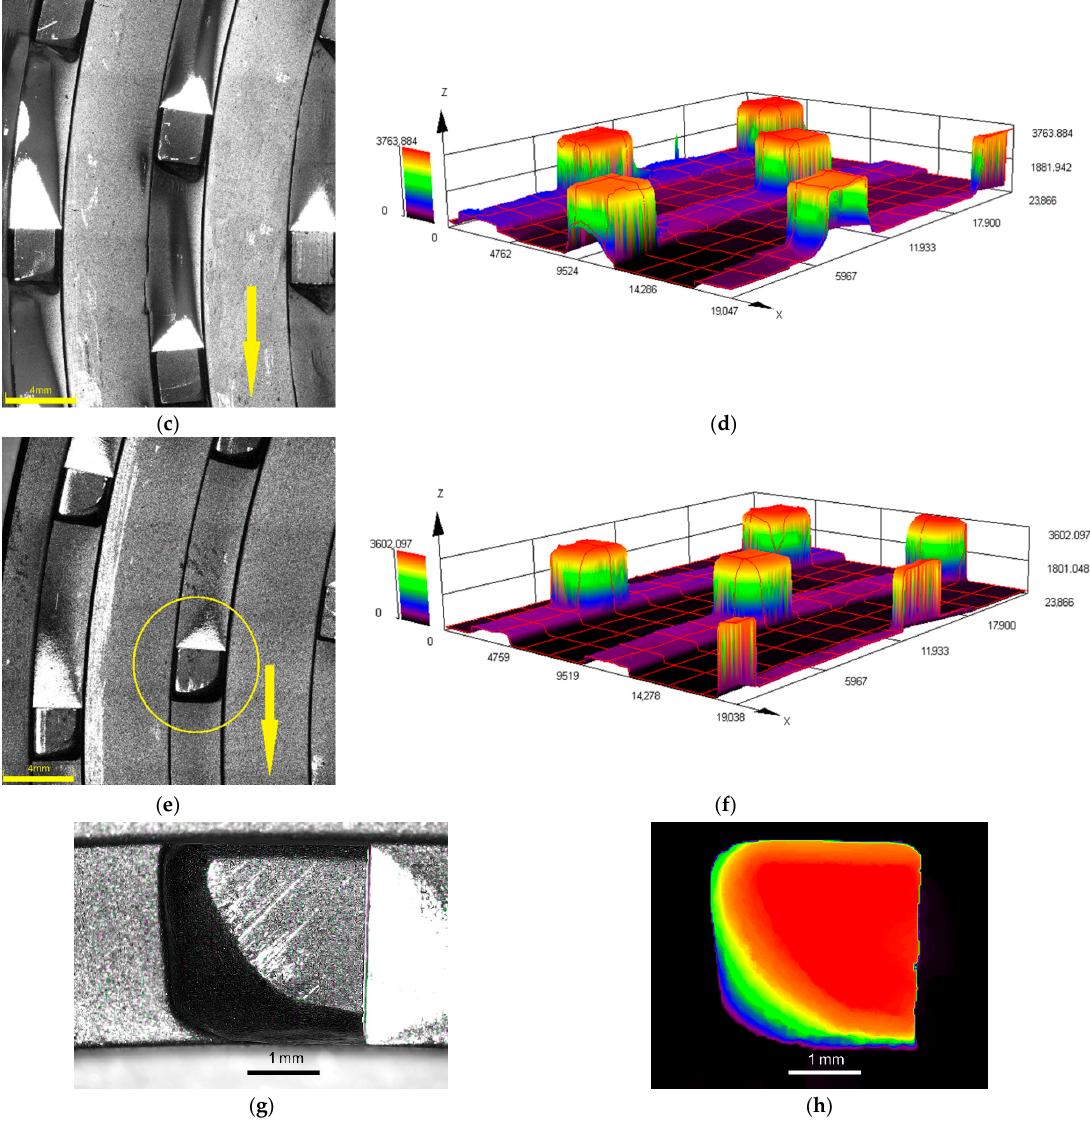
Figure 6. Optical images of new rotor: ( a ) 3D scan and ( b ) height profile of pins; optical images of rotor used for milling of 20 kg batch of 450 m 2 /kg sample: ( c ) 3D scan and ( d ) height profile of pins; optical images of rotor used for milling of 20 kg batch of 200 m 2 /kg sample: ( e ) 3D scan and ( f ) height profile of pins. Detailed images of pin marked by circle in ( f ) from rotor used for milling of 20 kg batch of 200 m 2 /kg sample: ( g ) detailed scan and ( h ) coloured profile. (Rotation directions marked by arrows).